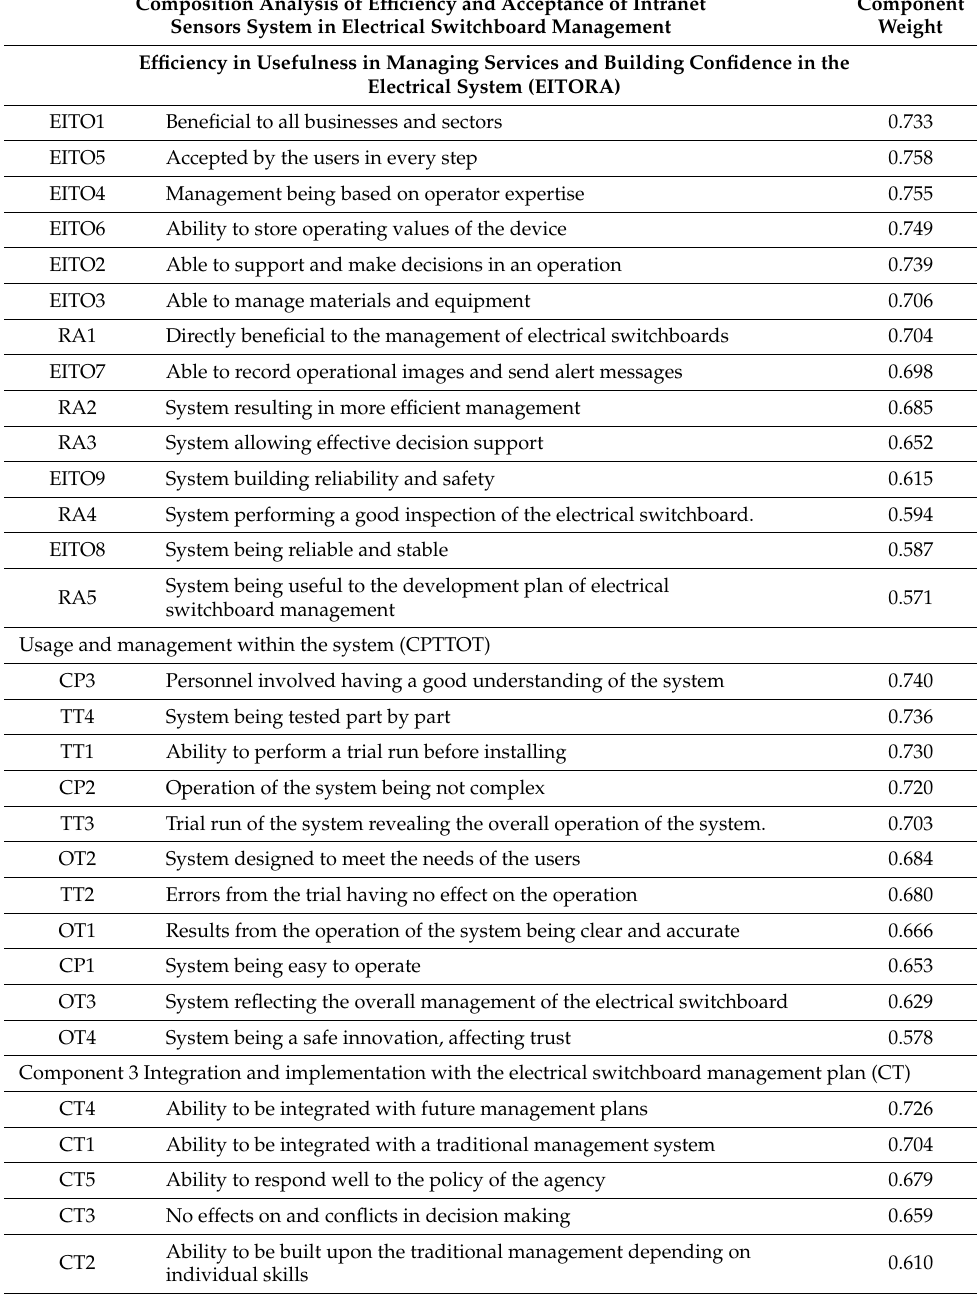
Table 4. Results of composition analysis of efficiency and acceptance of intranet sensors system in electrical switchboard